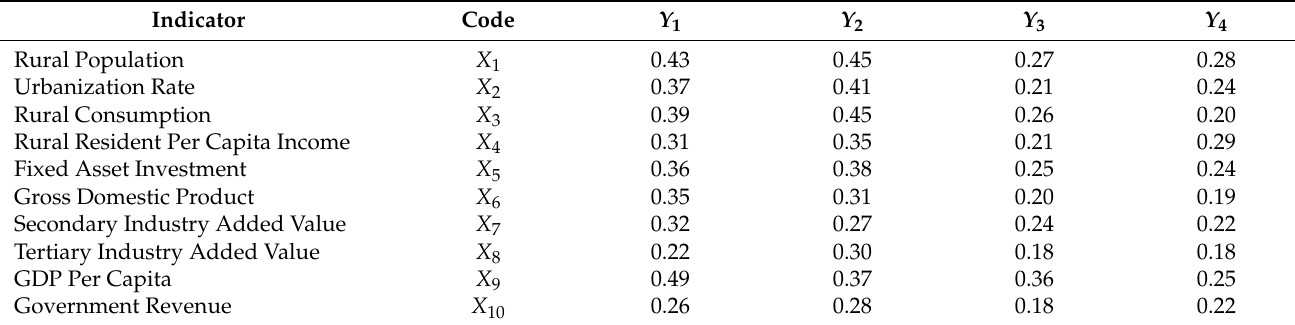
Table 8. Average value of factor interaction effect net